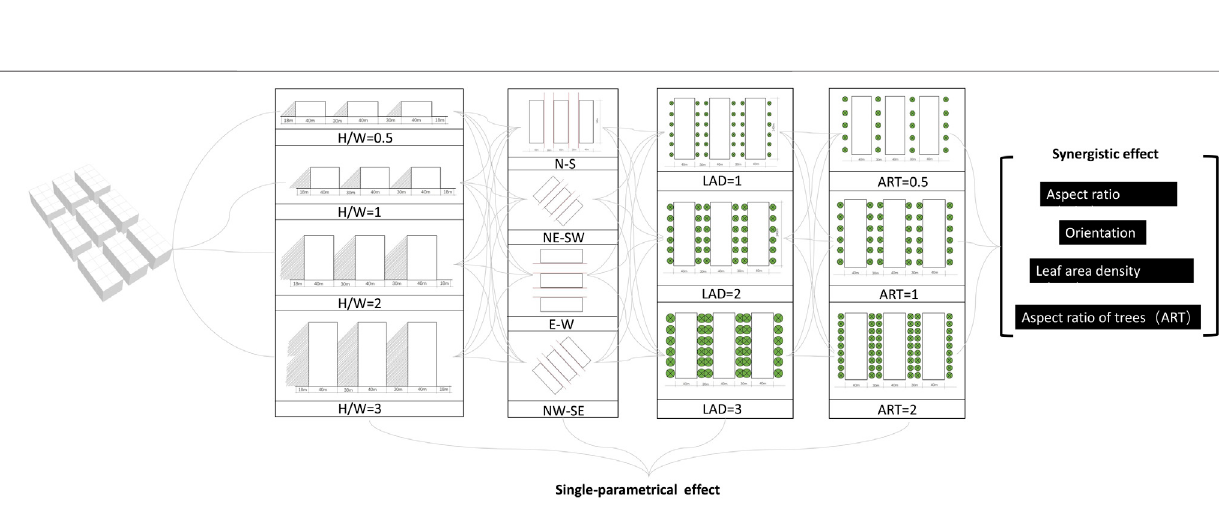
FIGURE 4 | Generative process diagram of the parametrical prototype